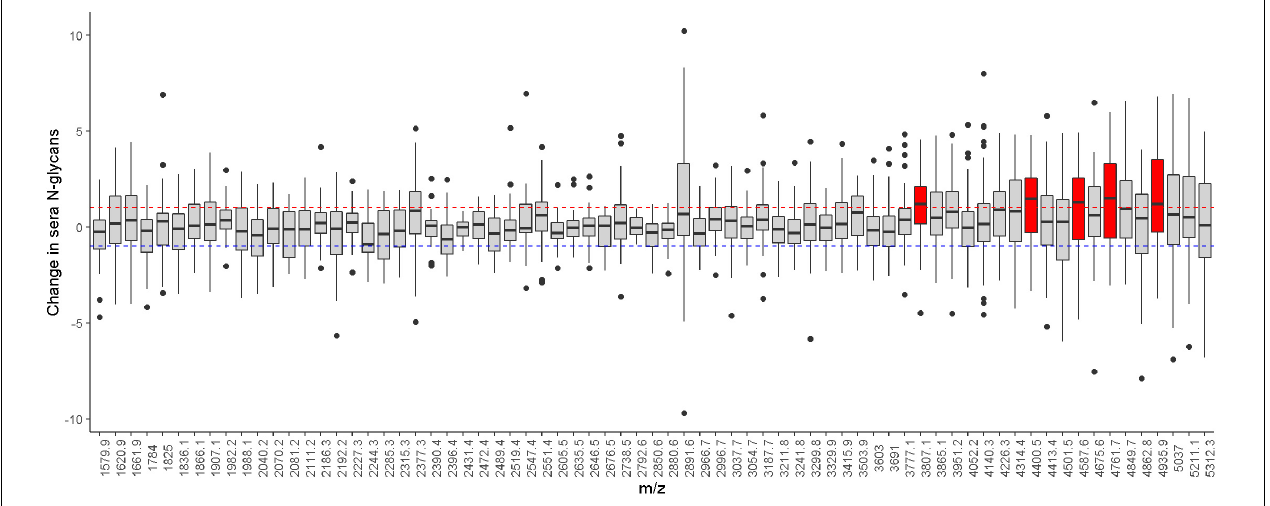
FIGURE 2 | Illustrates the level difference of sera N-glycans between baseline and proximate to death. Individual N-glycans are shown as m/z ratios on the x -axis. Horizontal dotted lines represent ± onefold change. Sera N-glycans that passed these thresholds are highlighted in red.